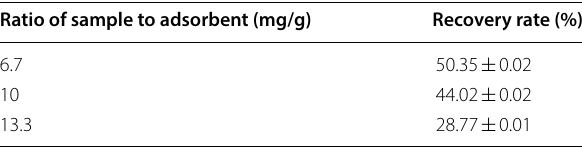
Table 3 The effect of different sample to adsorbent